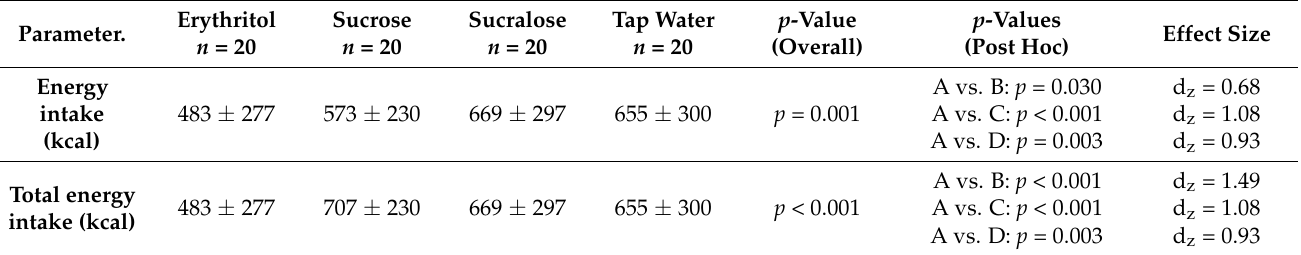
Table 1. Effects of preloads containing either (A) 50 g erythritol, (B) 33.5 g sucrose, (C) 0.0058 g sucralose, or (D) tap water on energy intake ( ad libitum test meal) and total energy intake (preload + ad libitum test meal) in 20 healthy participants 1 .